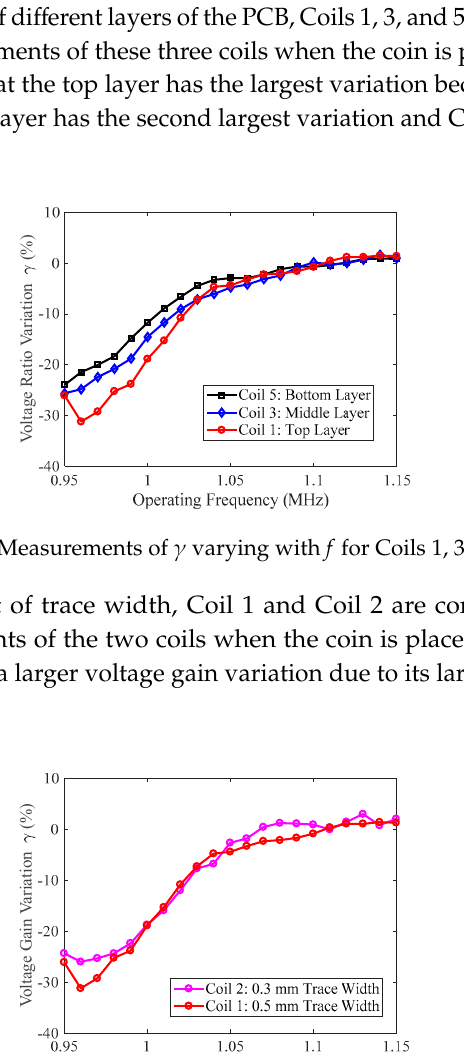
Figure 15. Measurements of γ varying with f under different values of λ for Coil 1.